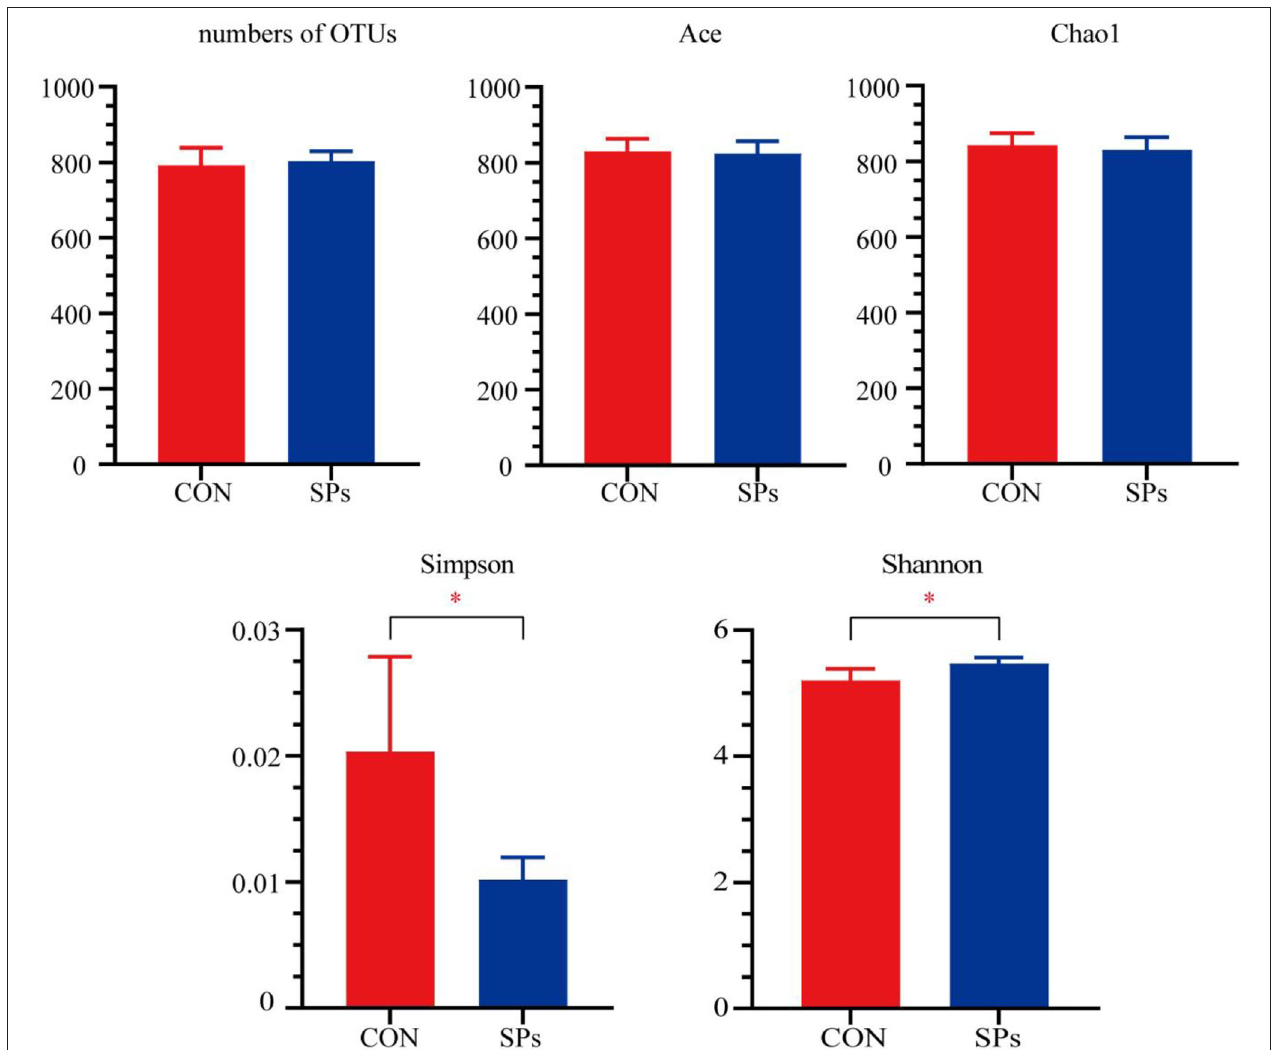
FIGURE 1 | Effects of the dietary supplementation of soybean peptides (SPs) on the alpha-diversity of rumen microbial communities. * , significant differences ( p < 0.05). CON, the control group with no soybean peptide supplementation; SPs, the group with 50 g/head/day of soybean peptide